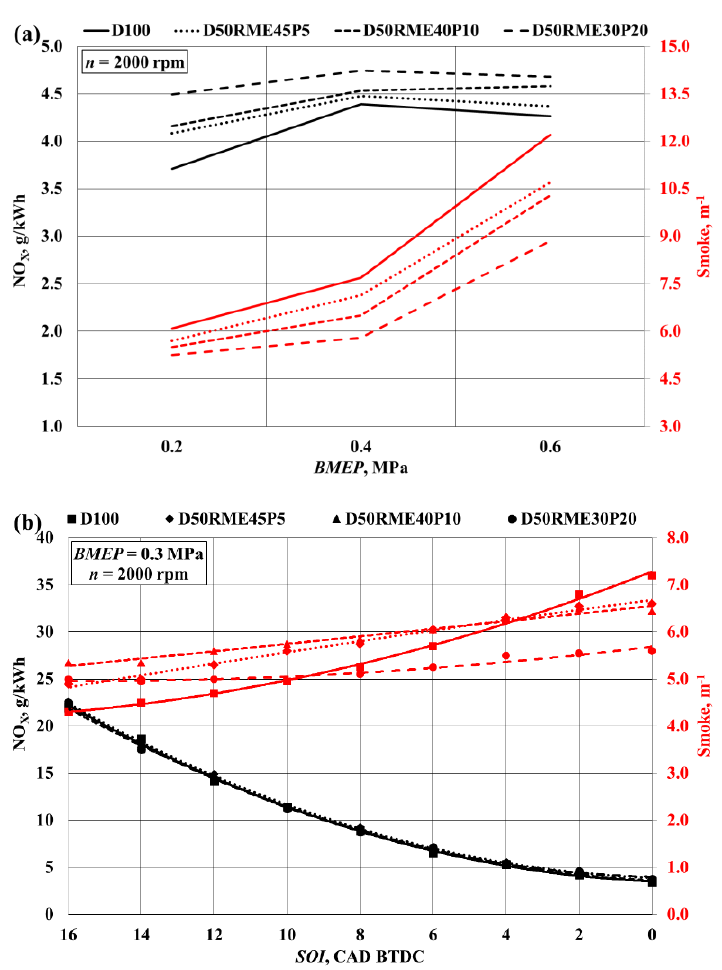
Figure 5. Dependence of nitrogen oxide emissions and smoke on different: ( a ) loads; ( b ) injection timing.